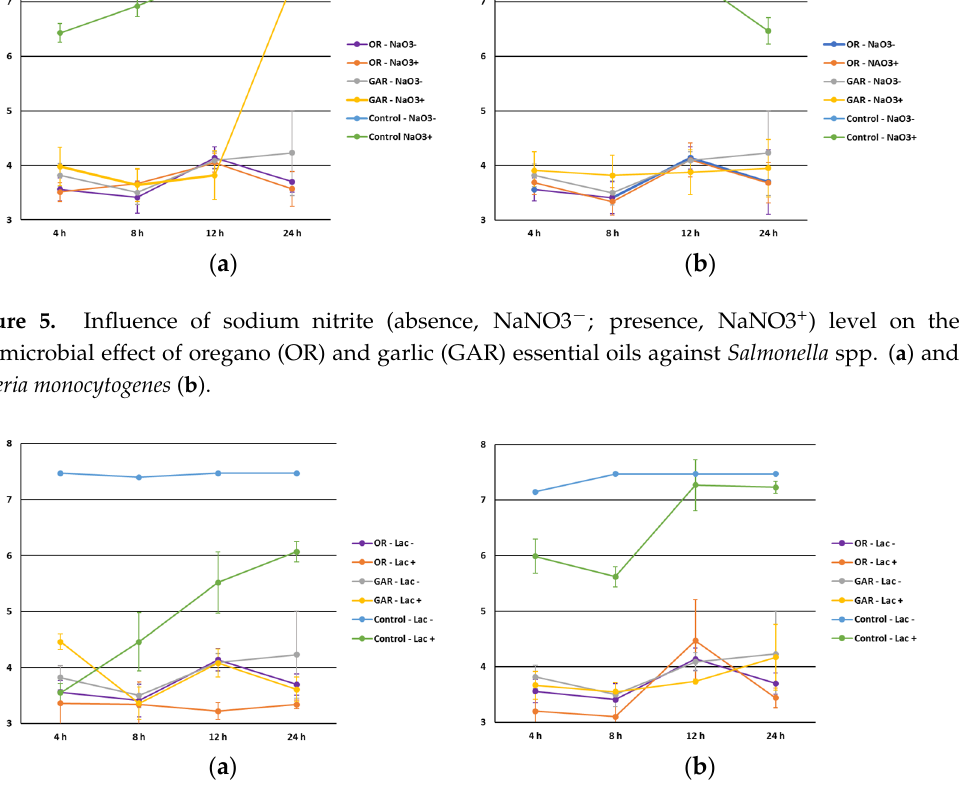
Figure 6. Influence of sodium lactate (absence, Lac − ; presence, Lac+) level on the antimicrobial effect of oregano (OR) and garlic (GAR) essential oils against Salmonella spp. ( a ) and Listeria monocytogenes ( b ).